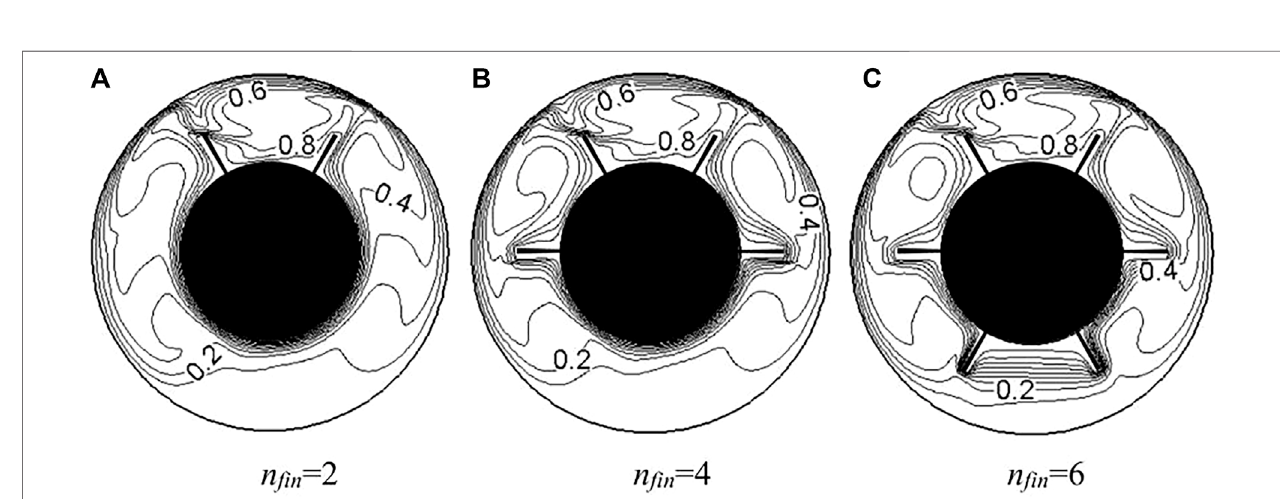
FIGURE 6 | Temperature fi elds with different fi n numbers for Ra (cid:1) 2 × 10 5 . (A) n fi n (cid:1) 2 (B) n fi n (cid:1) 4 (C) n fi n (cid:1) 6.